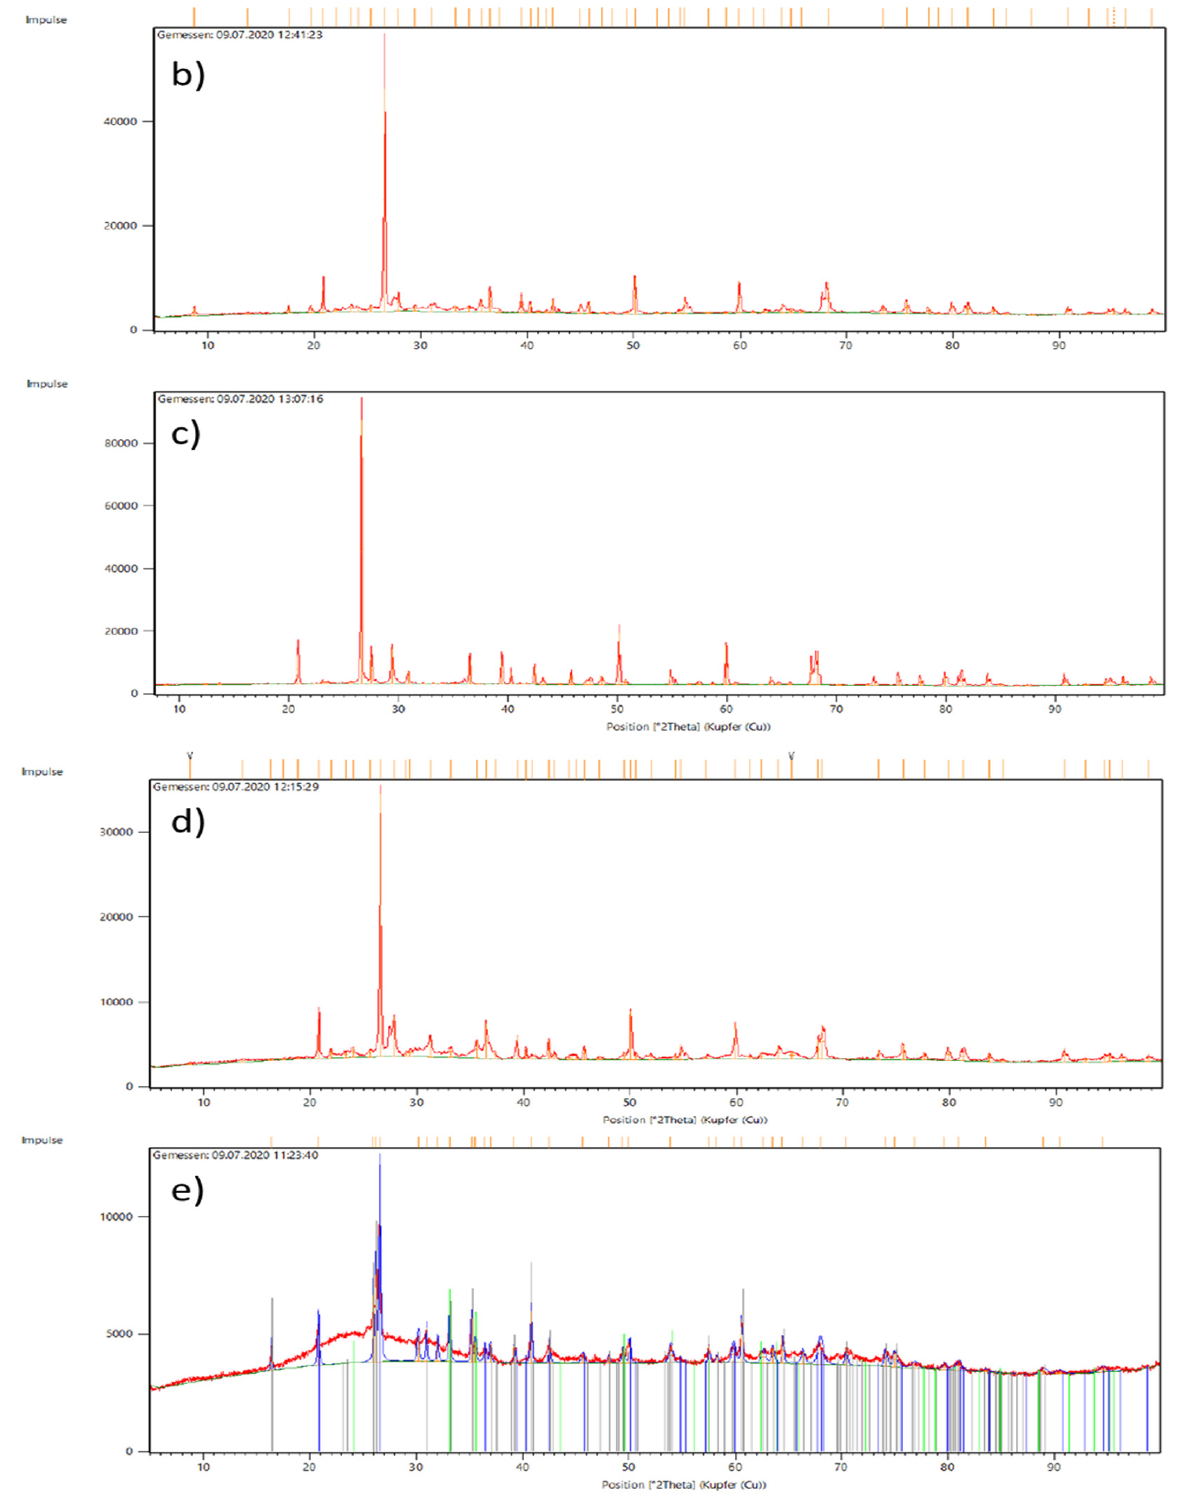
Figure 3. Mineralogical composition determined by XRD: ( a ) brick sanding dust; ( b ) brick scrap; ( c ) mixed rubble; ( d ) concrete rubble; ( e ) fly ash.